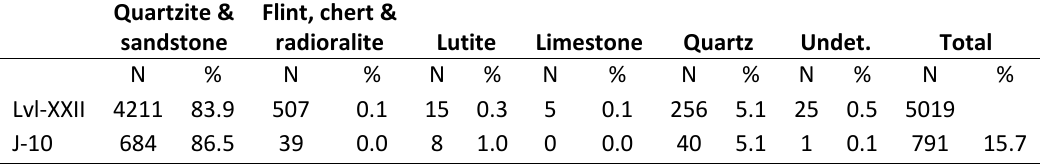
Table 2. Description of the lithic assemblages of Level XXII. Raw materials described for the complete level XXII and the sample taken from the sublevel XXII-R (J-10). N = total number Quartzite & Flint, chert & sandstone radioralite Lutite Limestone Quartz Undet.